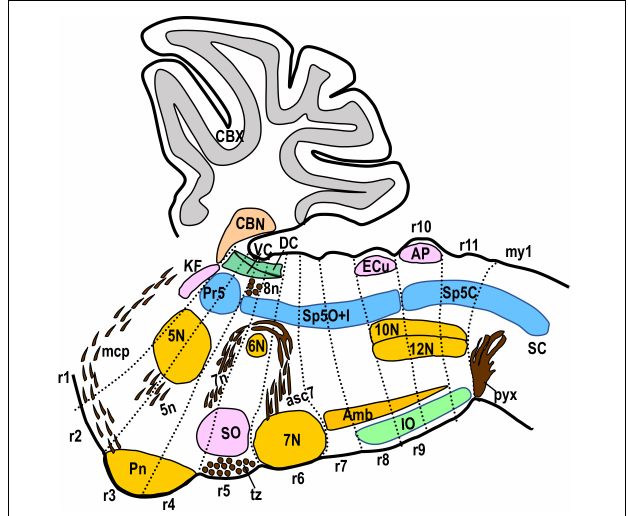
FIGURE 3 | Schematic drawing showing a sagittal view of the hindbrain plus the first myelomere with the morphological landmarks used to delimit the rhombomeric domains in this work. The Kolliker-Fuse nucleus (KF), the cerebellar cortex and nuclei (CBX, CBN) and the ventral nucleus of the lateral lemniscus (VLL) are located in r1. The medial cerebellar peduncle (mcp) crosses superficially r2 and r1. The dorsal and ventral cochlear nuclei (DC, VC) extend from r2 to r5. The trigeminal motor nucleus (5N) and the root of the trigeminal nerve (5n) are located across r2 and r3. The pontine nuclei (Pn) are located superficial and medially in r3 plus r4. The bundles of fibers of the vestibulocochlear nerve (8n) and the descending fibers of the facial nerve (7n) are in r4. The abducens motor nucleus (6N) is medially in r5. The superior olive (SO) and the trapezoid body (tz) are located principally in r5. The facial motor nucleus (7N) is located in r6, with its rostral and caudal ends bulging, respectively, into r5 and r7. The inferior olive (IO) extends from r8 to r11. The complex formed by the hypoglossal and vagal motor nuclei (12N, 10N) is located in r9, r10, and r11. The ambiguous motor nucleus (Amb) extends from r7 to r10. The external cuneatus nucleus (ECu) appears in r9 at lateral section levels. The area postrema (AP) is located at the midline in r10. The pyramidal decussation (pyx) is located in the first myelomere (my1). Concerning the trigeminal column, the principal sensory nucleus (Pr5) is located in r2 and r3, while the spinal trigeminal nucleus (Sp5) extends from r4 caudalwards. Within Sp5, the limit between interpolar and caudal subnuclei is located at the r9/r10 limit. We have drawn Sp5 including the dorsal horn of the first myelomere, considering their similarity in morphology and gene